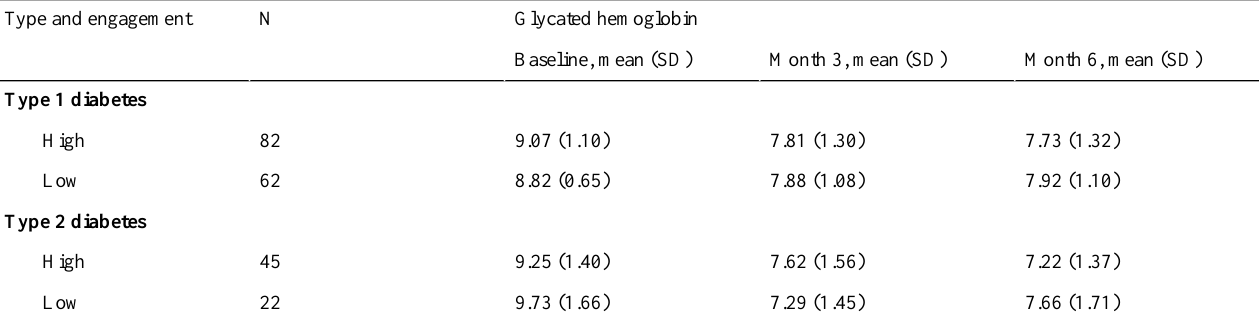
Glycated hemoglobinNType and